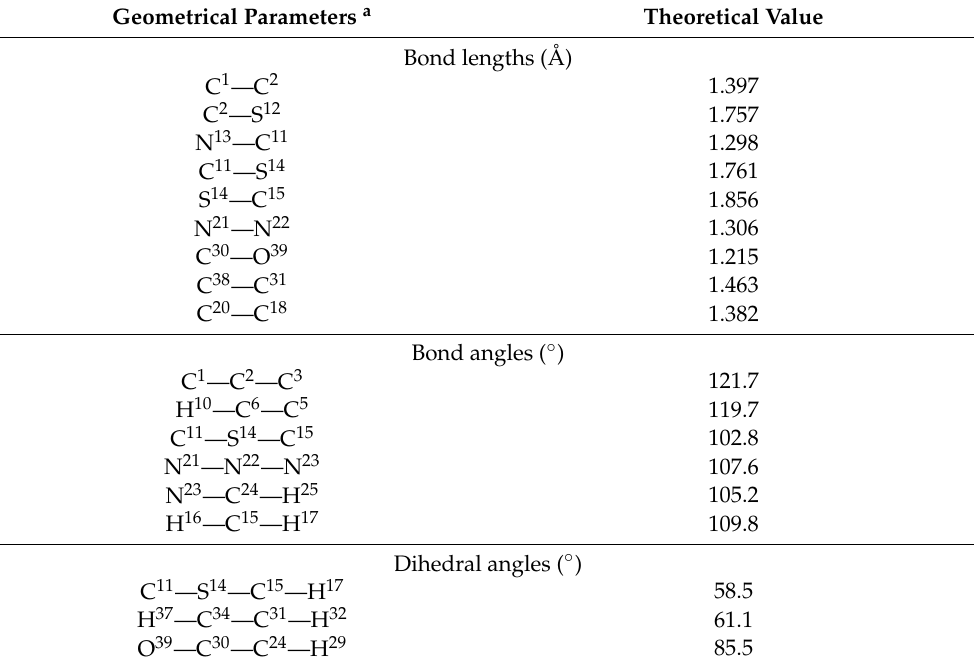
Table 3. The calculated structural parameters of 5e by the B3LYP/6-31 + G(d, p ) method. Geometrical Parameters a